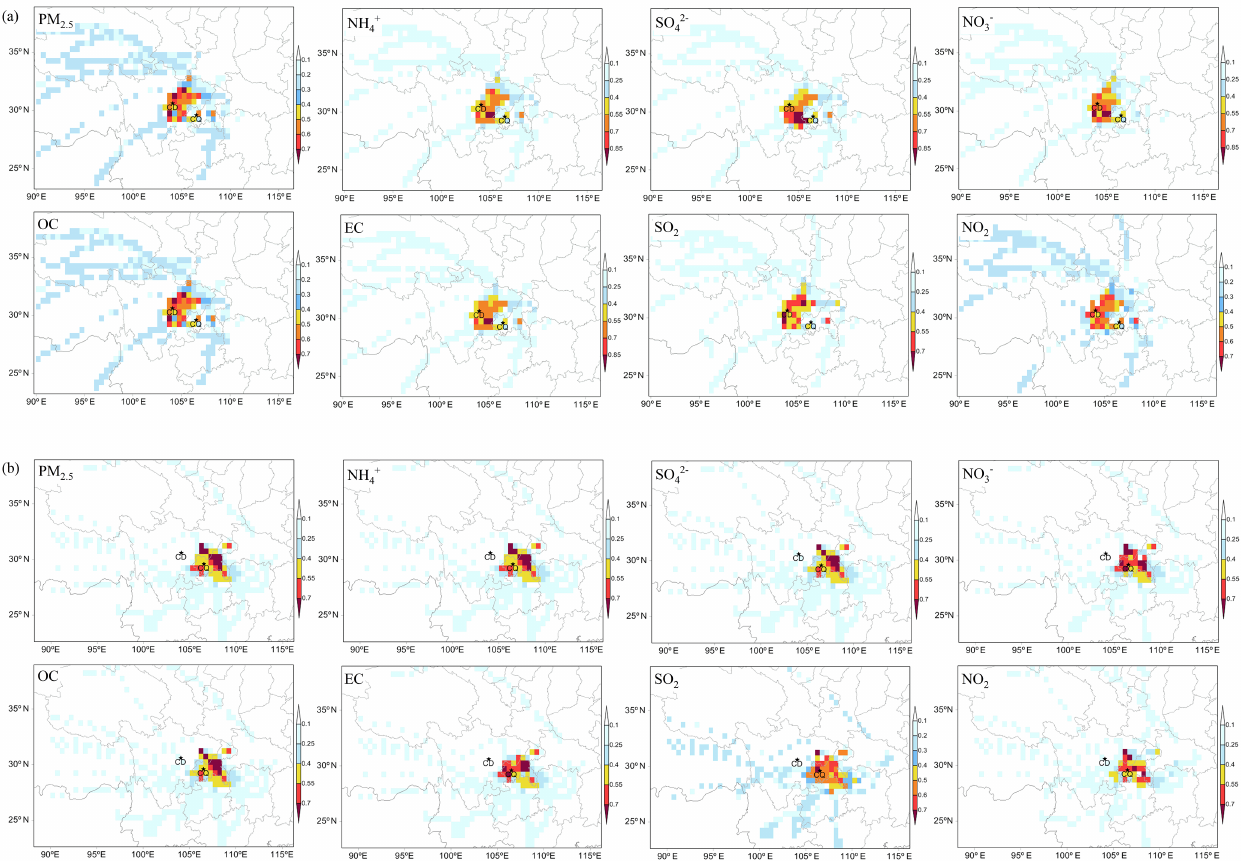
Figure 10. PSCF distribution of PM 2 . 5 , its chemical components, and gaseous precursors in winter at CD (a) and CQ (b)